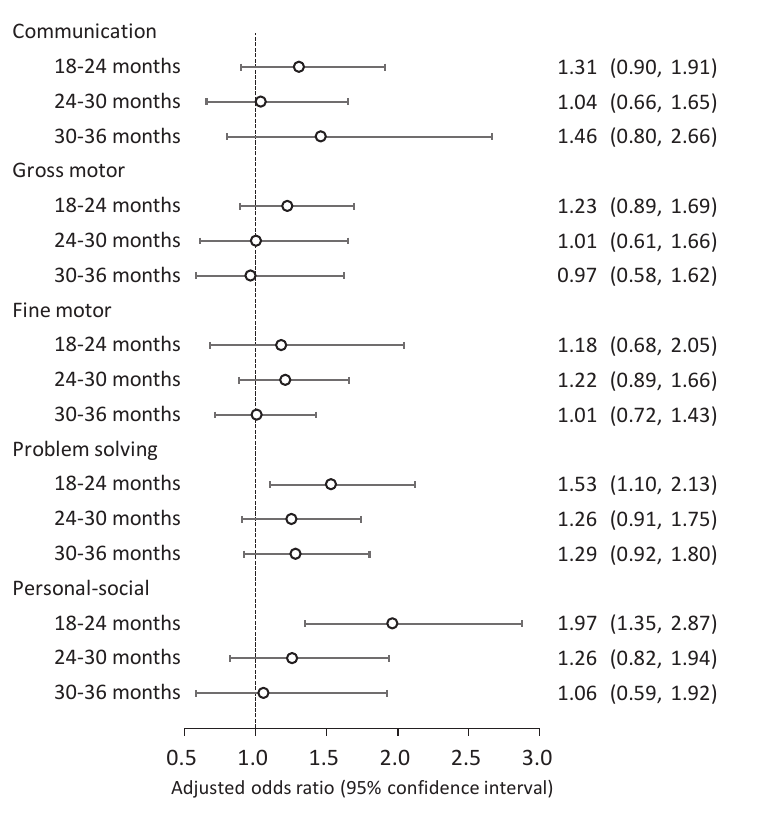
Fig. 4 Association of epidural analgesia during labor with the incidence of neurodevelopmental delay among children Adjusted odds ratios (95% con fi dence intervals) for the incidence of neurodevelopmental delay in each domain of the J-ASQ-3 among children born to mothers who received epidural analgesia during labor are shown, every 6 months after 18 months. Adjusted for maternal age at delivery, parity, delivery mode, duration of labor, comorbidity (diabetes and hypertension), body mass index before pregnancy, occupation in the fi rst trimester, smoking status, alcohol consumption, educational level, annual household income, marital status at 6 months after childbirth, child ’ s sex, birth weight, Apgar score at 5min after birth, feeding methods in infancy, nursery attendance, screen time at 12 months old, siblings cohabiting with the child, and study area. A multiple imputation method was used to reduce potential selection bias from missing variables. Abbreviations: J-ASQ-3, the Japanese translation of the Ages and Stages Questionnaires, Third